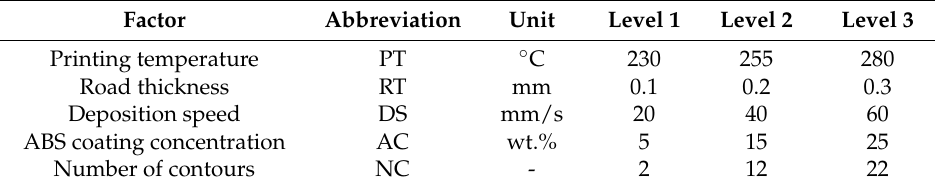
Table 3. AddJoining process parameters range for the OFAT.